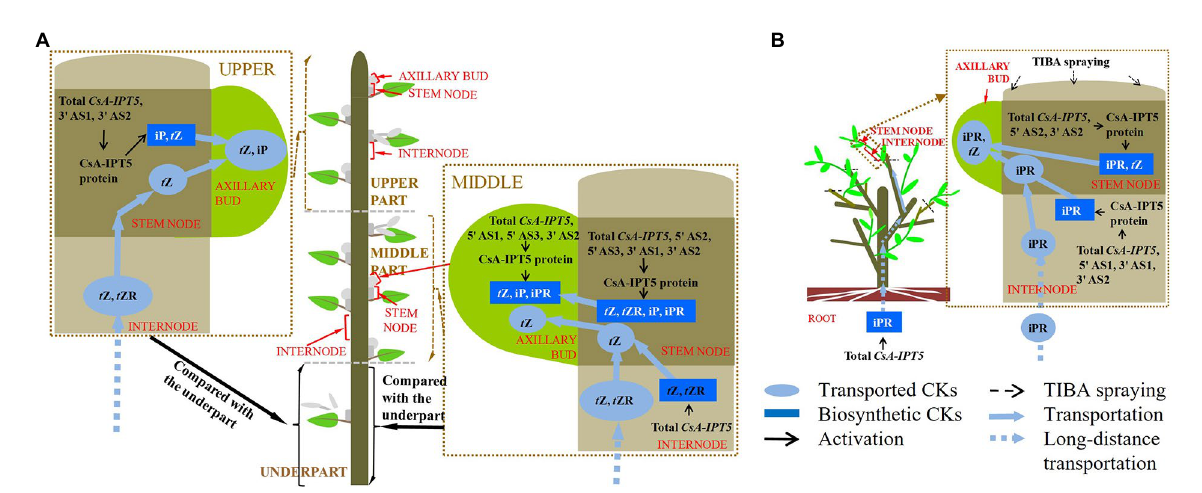
FIGURE 5 A proposed model of CsA-IPT5 transcripts in the regulation of the distal branching habit of new shoots (A) and shoot branching stimulated by TIBA spraying (B) in tea plants. Each shoot branching process regulated by CsA-IPT5 transcripts is included in a single rectangle surrounded by brown dashed lines, respectively. Light blue ellipses represent the transported CKs. Blue rectangles represent locally biosynthesized CKs. Black arrows represent activation. Black dashed arrows represent exogenous TIBA spraying. Light blue solid arrows represent transportation, whereas light blue dashed arrows represent long-distance